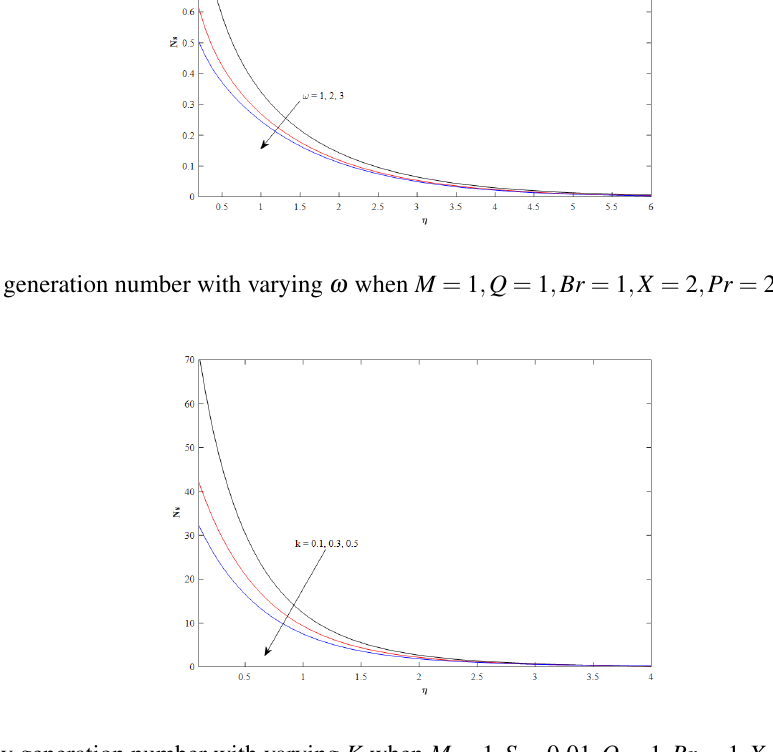
Fig. 6 Entropy generation number with varying K when M = 1 , S = 0 . 01 , Q = 1 , Br = 1 , X = 2 , Pr = 2 , ω = 1.